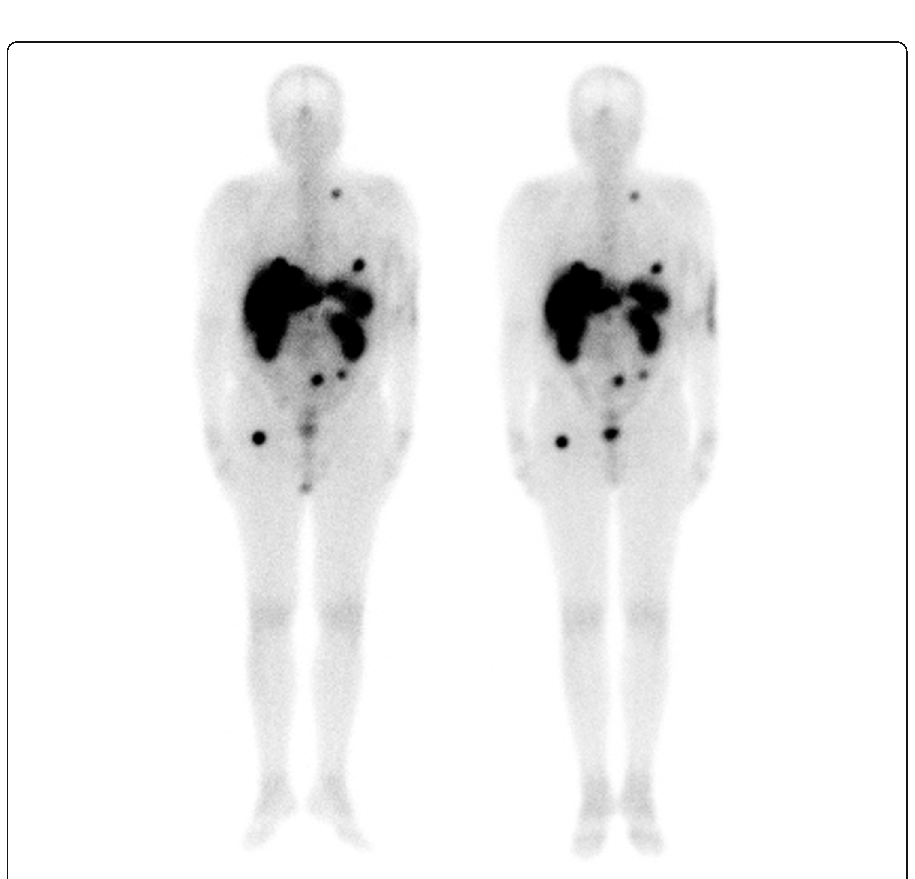
Fig. 7 Geometric mean of whole body images acquired at T 20h (left) and T 26h